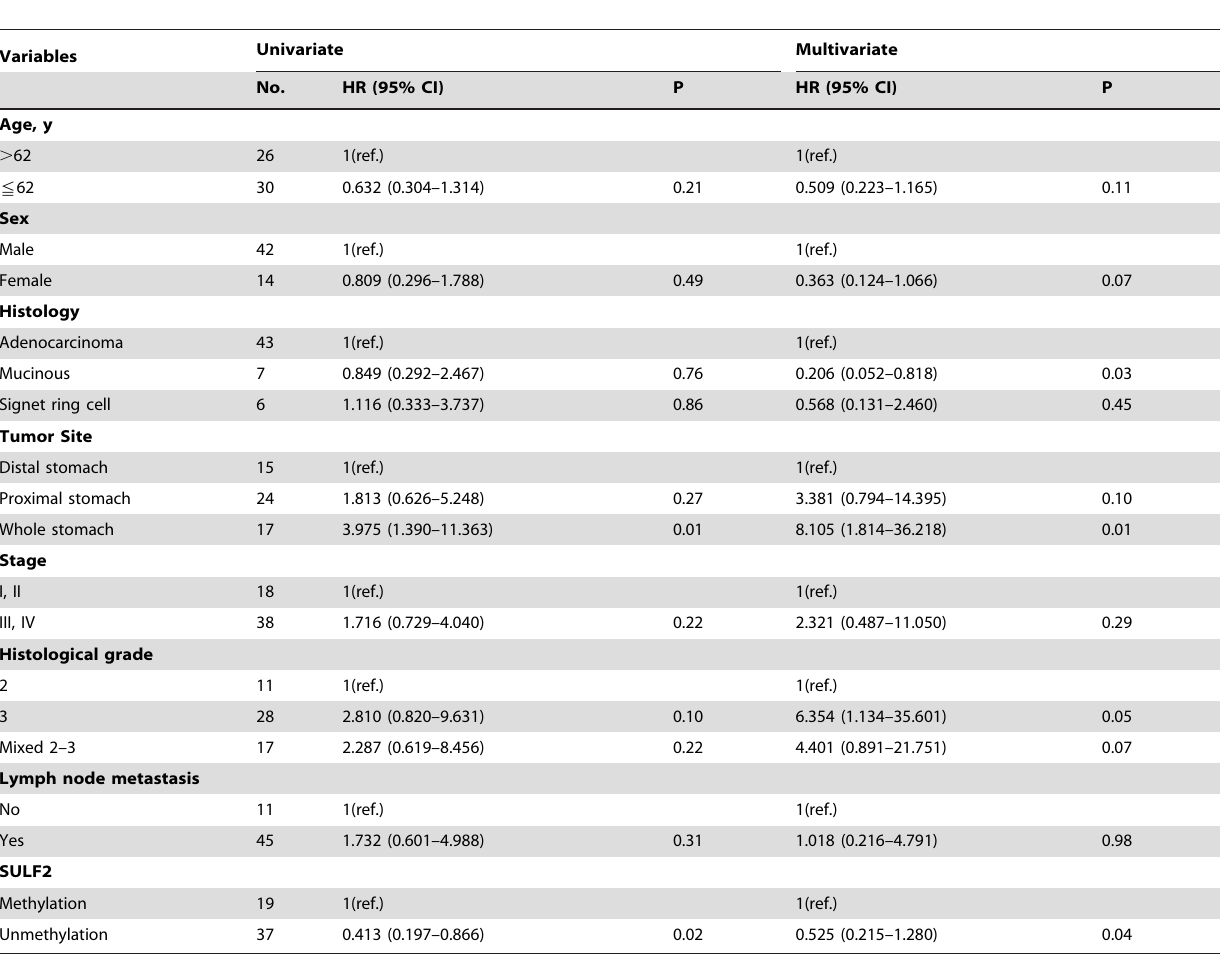
Table 6. Univariate and multivariate Cox proportional hazard analysis of factors associated with overall